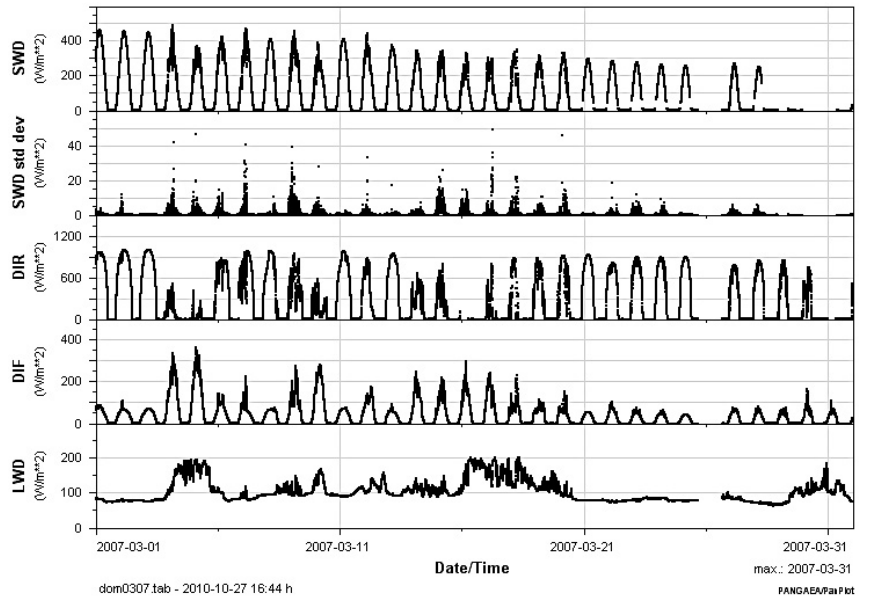
Figure 2. Example of PanPlot at work. It is free tool developed for time series visualization of data stored in PANGAEA archive format. In this example the downwelling components SWD, DIR, DIF and LWD, and the standard deviation of the global shortwave are shown for March 2007 at Dome